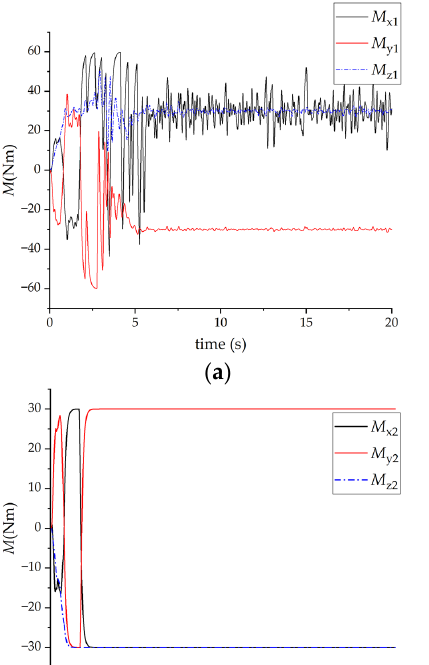
Figure 17. The output of the virtual force sensor in the first experiment: ( a ) output torque profiles of the virtual force sensor 1; ( b ) output force profiles of the virtual force sensor 1; ( c ) output torque profiles of the virtual force sensor 2; and ( d ) output force profiles of the virtual force sensor 2.